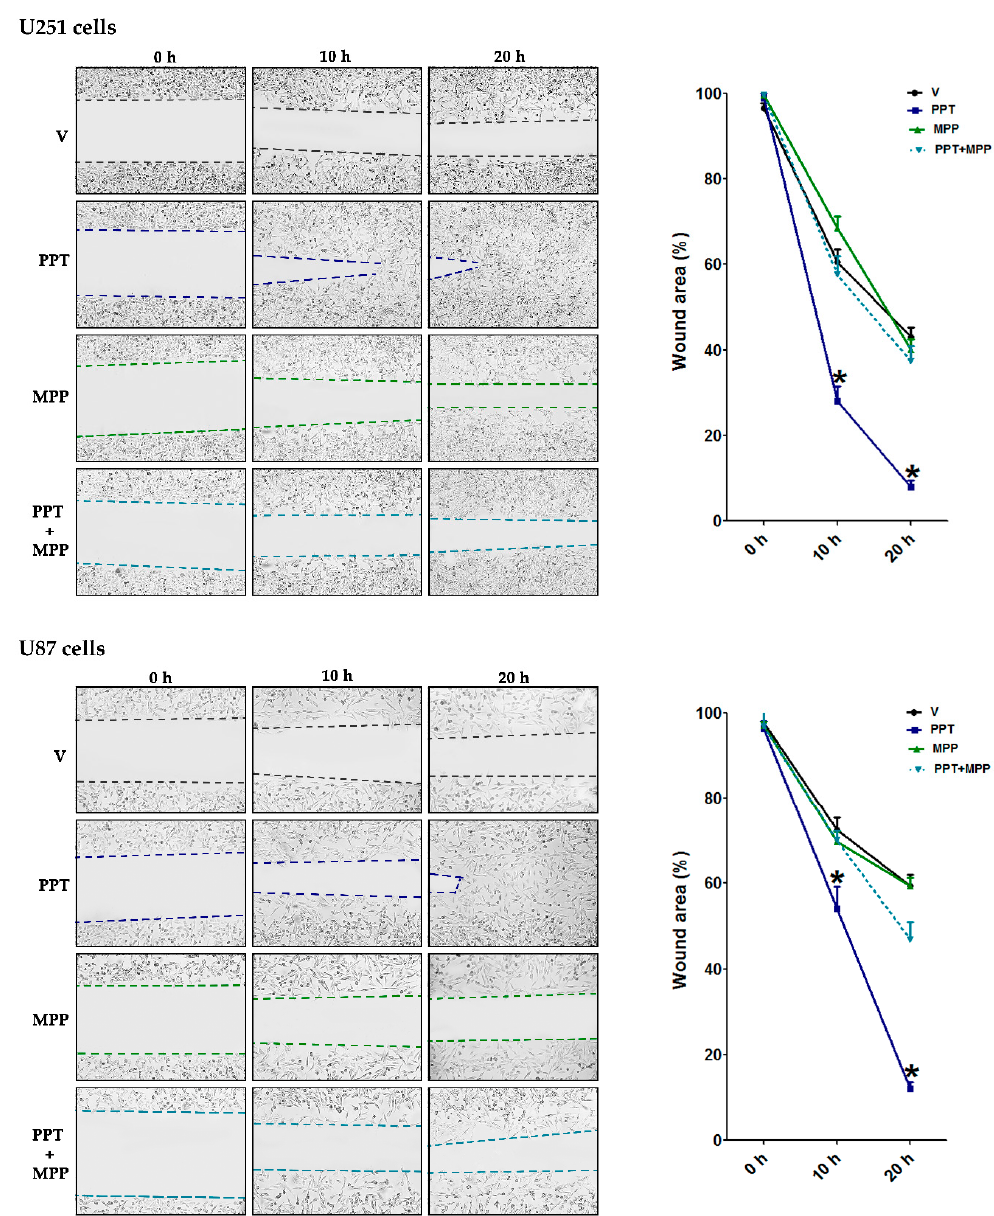
Figure 8. Effect of the selective ER- α agonist and antagonist on the migration of GBM cells. ( A ) U251 and ( B ) U87 cells that were treated for 20 h, with PPT (10 nM, selective ER- α agonist), MPP (1 μ M, selective ER- α antagonist), PPT + MPP, and vehicle (V, DMSO 0.01%). Wound healing assays determined the migratory capacity of the U251 and U87 cells. Representative images show wound closure at 0, 10, and 20 h and quantification of the wound area. Results are expressed as the mean ± standard error of the mean (SEM); n = 3; * p < 0.05 vs. all other groups.